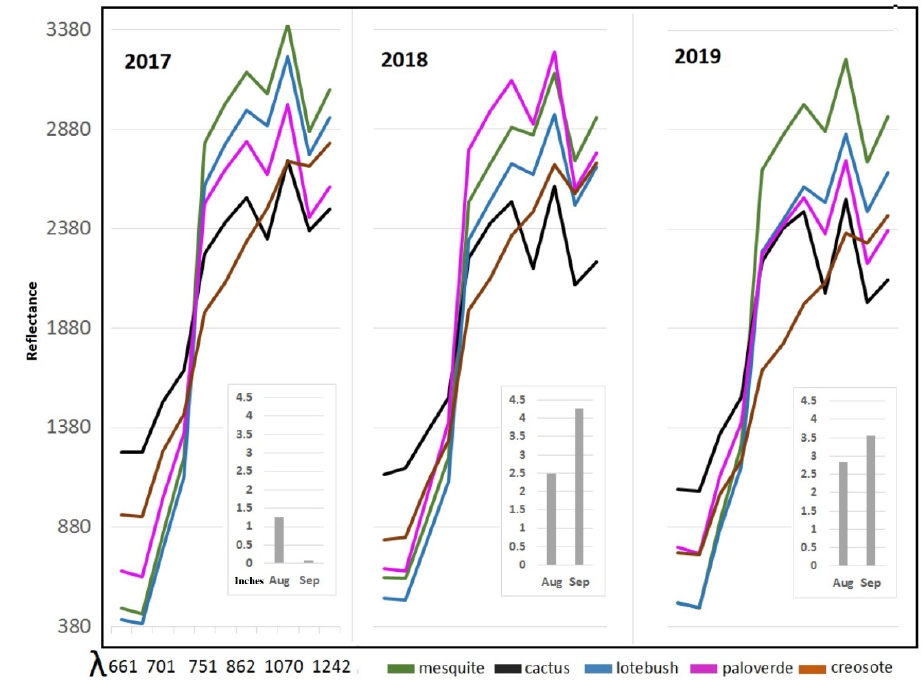
Figure 5. Rainfall events at time of data acquisition and mean reflectance curves by class for hyper- spectral bands used in highest variable importance (CACTI and NDVI) for the classification with the highest OA classification.